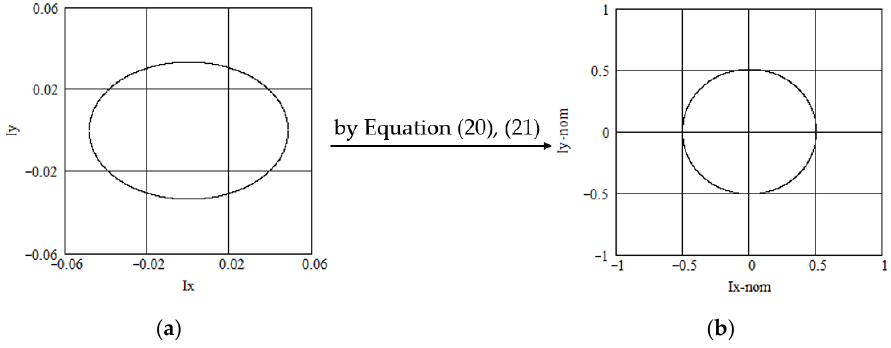
Figure 7. Orthogonal signal of proposed differential quadrature Fabry–Pérot interferometer. ( a ) Original signal; ( b ) Signal with mean normalization processing.